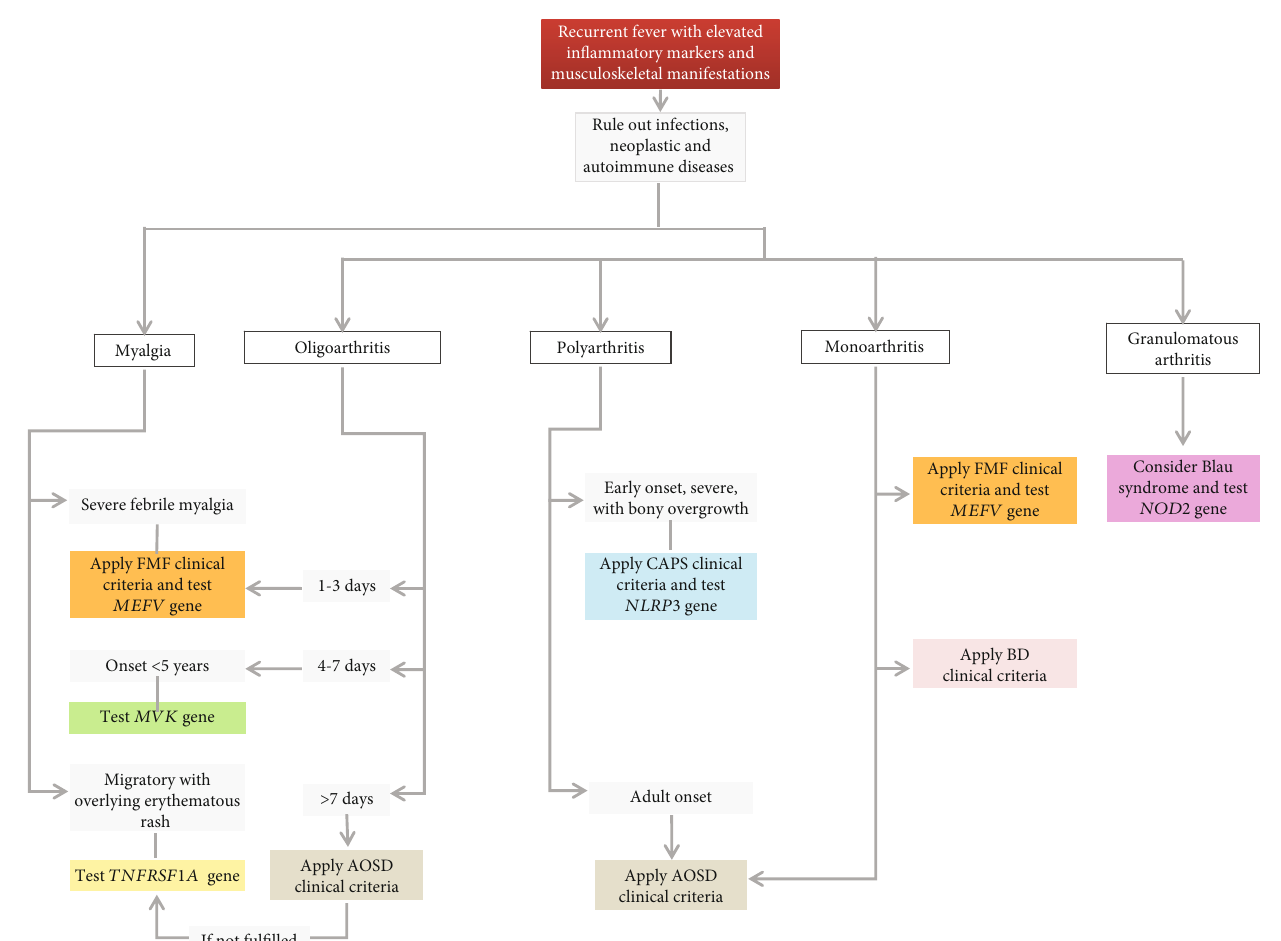
Figure 3: Diagnostic fl ow chart for main autoin fl ammatory diseases displaying recurrent fevers and musculoskeletal manifestations. List of abbreviations: FMF — familial Mediterranean fever; AOSD — adult-onset Still ’ s disease; BD — Behçet ’ s disease; CAPS — cryopyrin-associated periodic